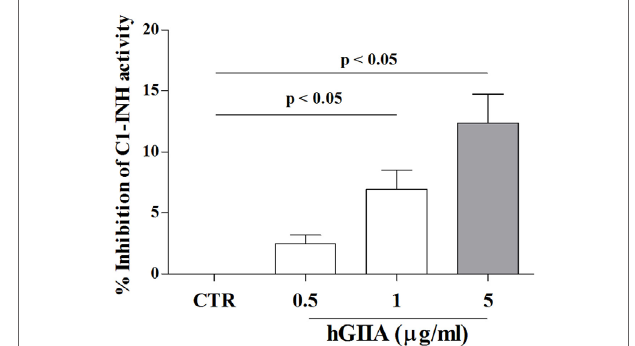
FigUre 6 | Effect of hGIIA on C1-INH activity. Plasma from normal donors was incubated (2 h, 37°C) with increasing concentrations (0.5–5 µg/ml) of hGIIA or with medium alone and then functional activity of C1-INH was evaluated by colorimetric assay. Data are expressed as percent inhibition of the maximum plasma activity of C1-INH calculated as ( R − R b ) × 100, where R is the C1-INH activity in plasma samples treated with the hGIIA, R b is the C1-INH activity in unstimulated samples. Data are the mean ± SD of 15 experiments.